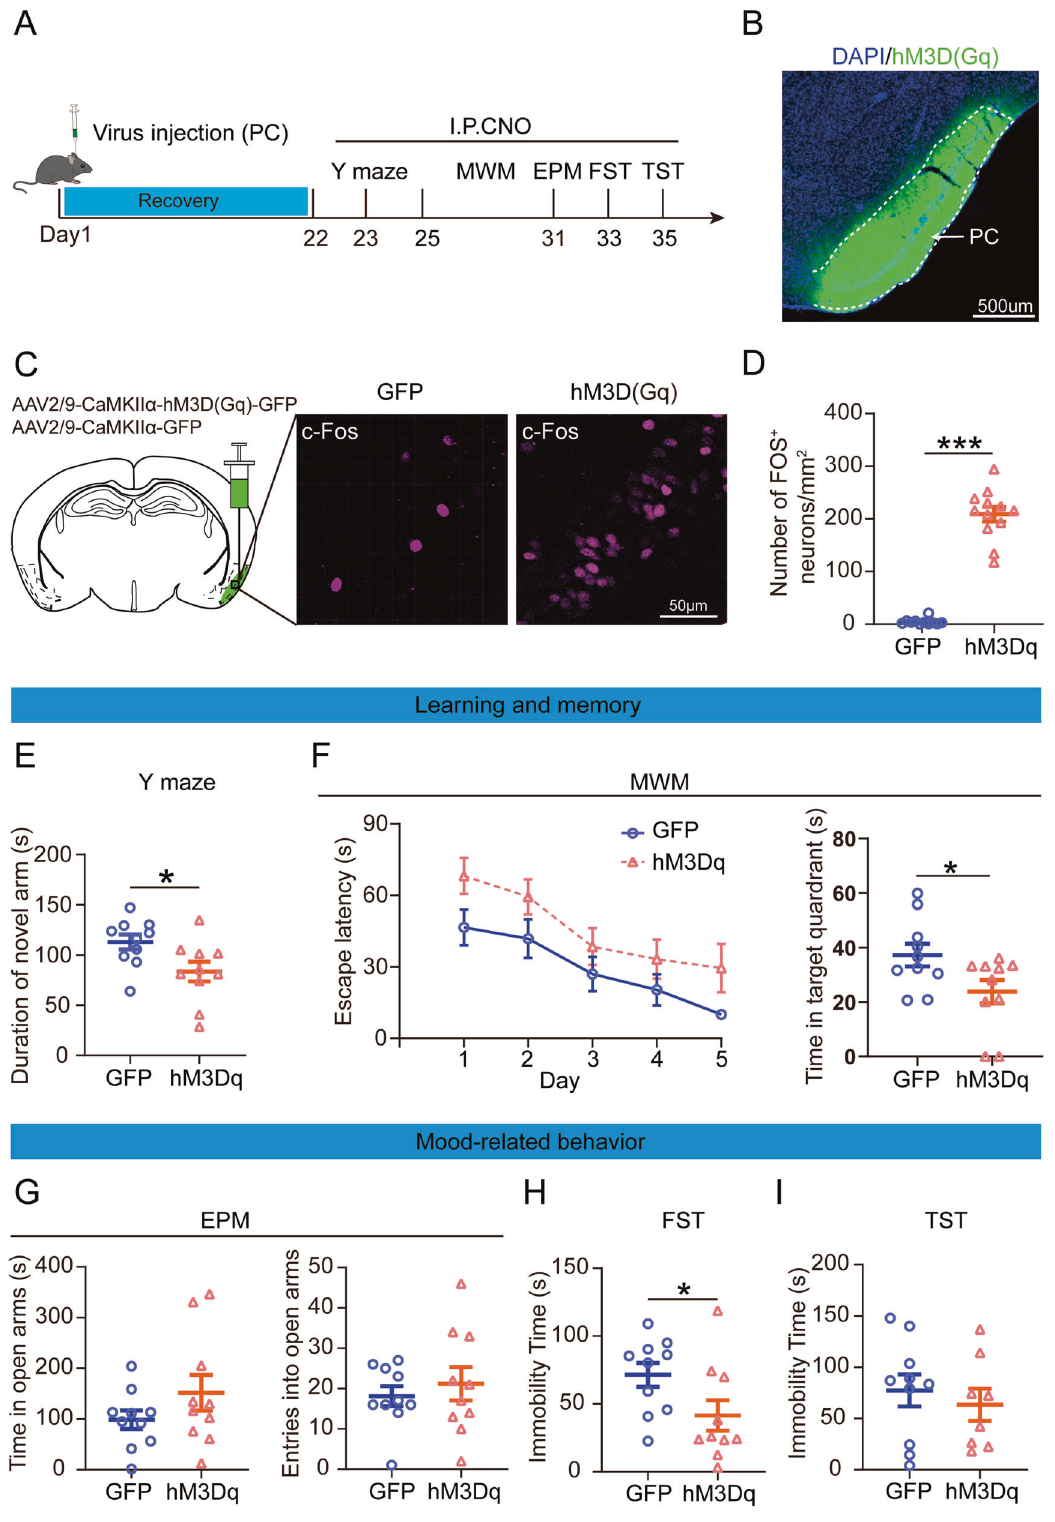
could alleviate CSDS-induced learning and memory dysfunction. Next, we inhibited PC CaMKII α expressing neurons during behavior testing using the chemogenetic method (Fig. 5A). We injected AAV2/9-CaMKII α -hM4D(Gi)-GFP or AAV2/9-CaMKII α -GFP into the PC (Fig. 5B, C). To con fi rm the function of hM4D(Gi), neuronal